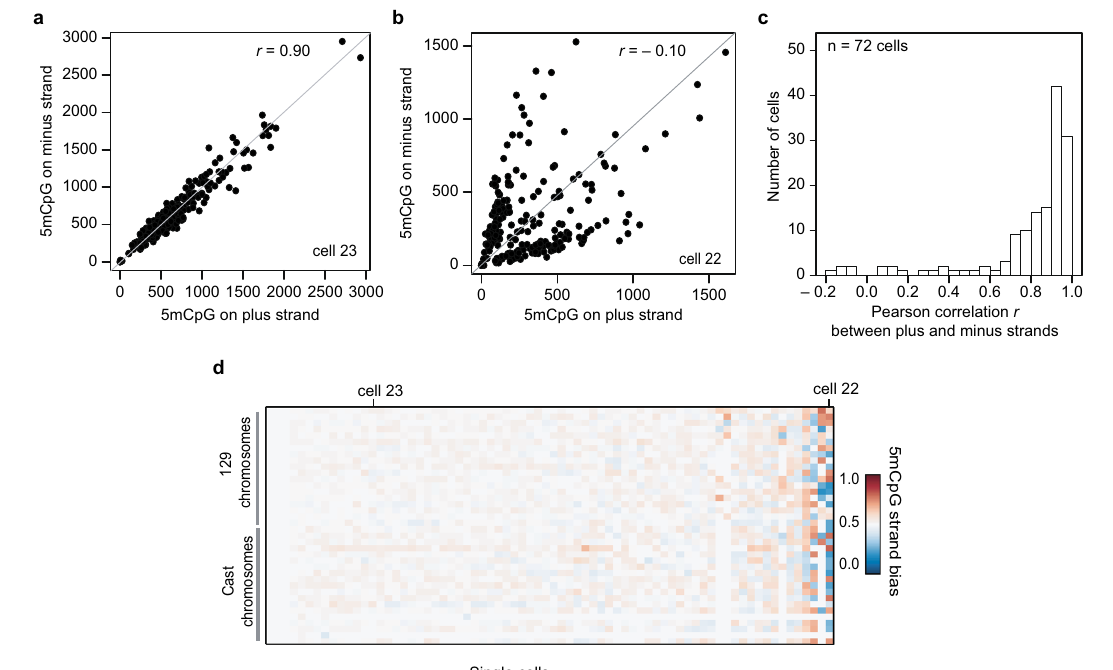
Fig. 3 Variability in strand-speci fi c 5mCpG pro fi les in mES cells. a A representative mES cell (cell #23) with similar amounts of 5mCpG within 10 Mb bins on both DNA strands. b Another representative mES cell (cell #22) with unequal amounts of 5mCpG between the two DNA strands for 10 Mb bins. c Histogram of Pearson correlations between the 5mCpG levels on the plus and minus stands over the entire genome (10 Mb) in a cell. d Ordered heatmap showing 5mCpG strand bias per chromosome for maternal and paternal alleles in individual mES cells ( n = 72). The results in this fi gure are based on strand-speci fi c reanalysis of single-cell bisul fi te sequencing data obtained from previous work by Clark et al. 25